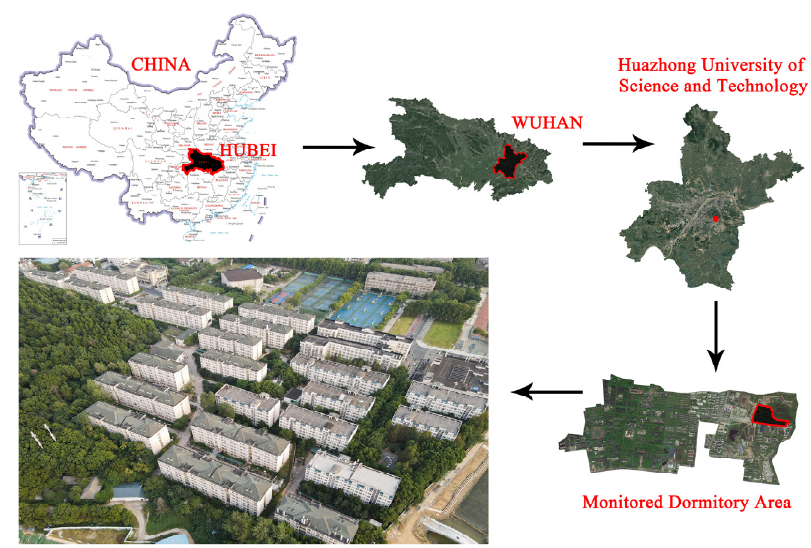
Figure 6. Location and photograph of 20 selected dormitory buildings.